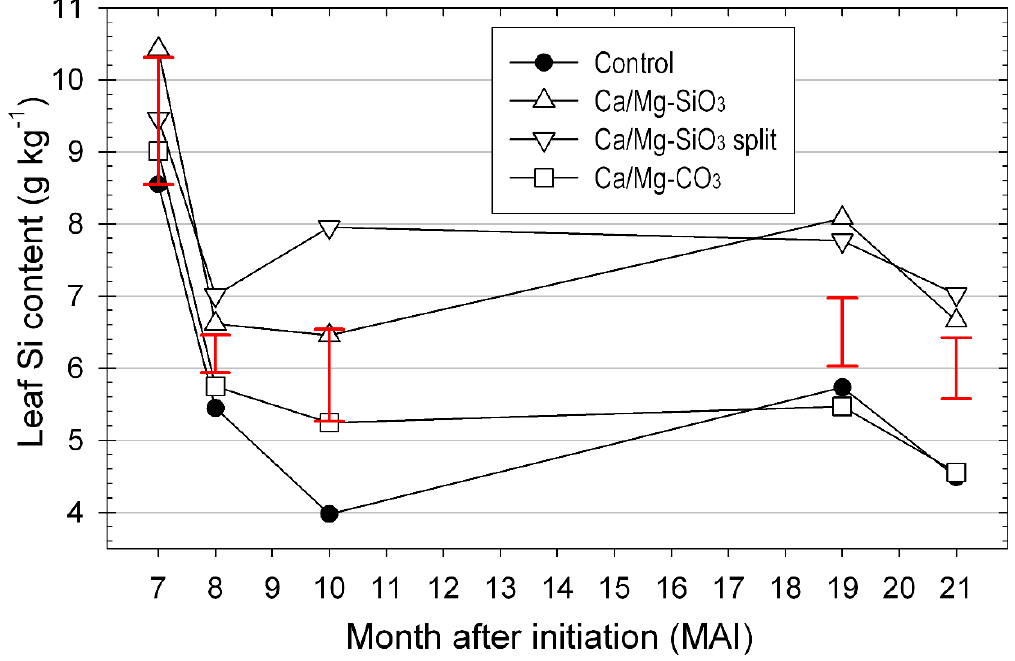
Figure 4. Leaf silicon concentration by liming agent treatment and month after initiation (MAI). For MAI specified, error bars depict least significant difference (alpha = 0.05) between